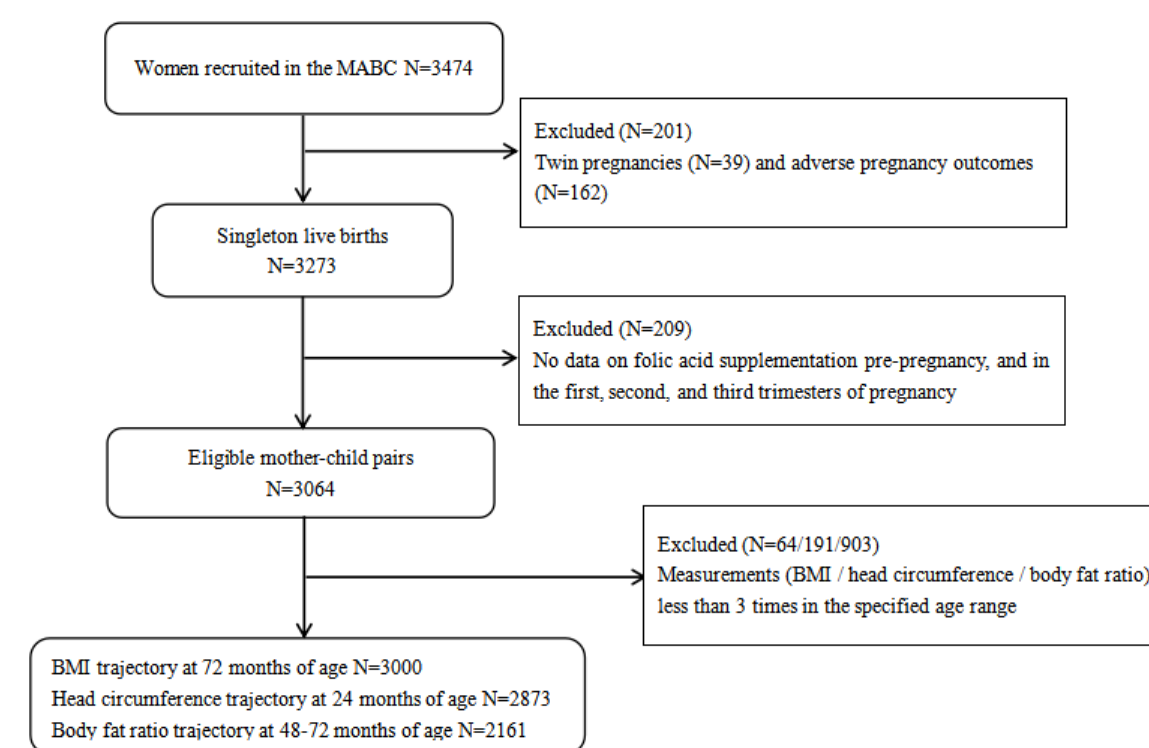
Figure 2. Flowchart of study participants.